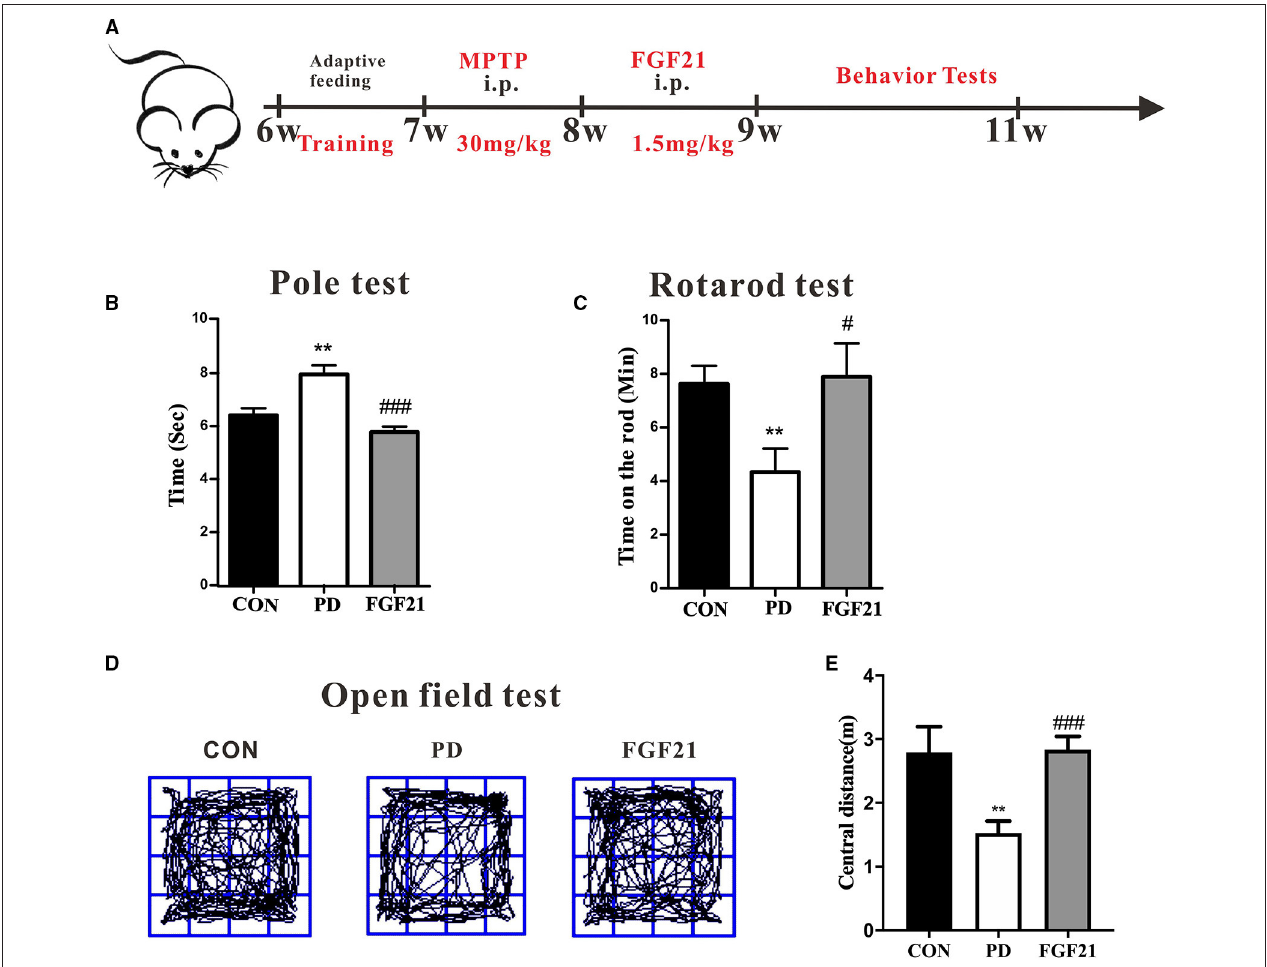
FIGURE 1 | Fibroblast growth factor 21 (FGF21) treatment prevented the motor deficits of mice with PD. (A) Schematic of the experimental procedure. (B) Time to descend pole. (C) Rotarod test. (D) Track of mice in open field test. (E) Distance traveled in the center for 5min. Data are mean ± s.e.m.; n = 6–8 for each group. One-way ANOVA was conducted for statistical analysis followed by an LSD multiple comparison test. ** P < 0.01 vs. control (CON) group; # P < 0.05, ### P < 0.001 vs. 1-methyl-4-phenyl-1,2,3,6-tetrahydropyridine (MPTP)-injected